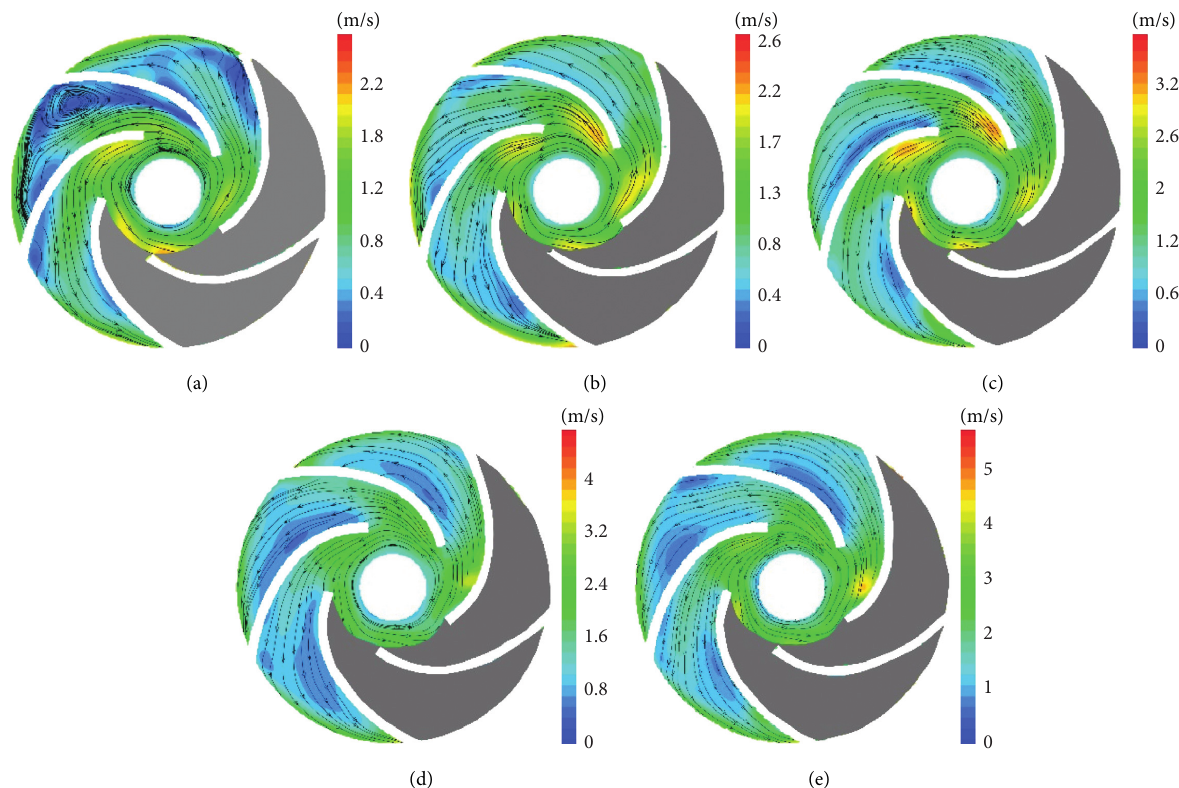
BEP , (b) 800r/min 1.0